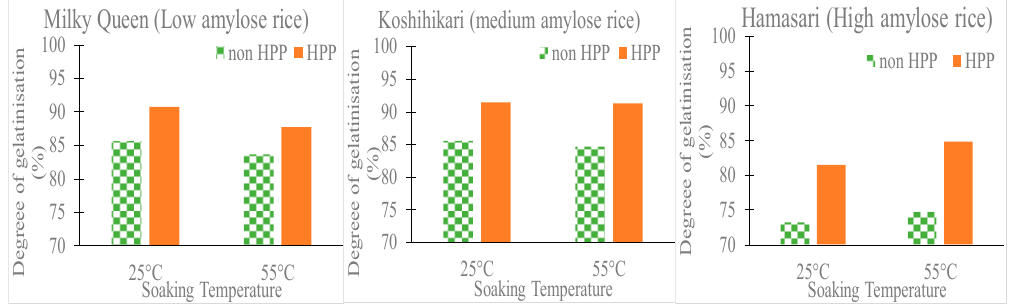
Figure 8. Comparison of the degree of gelatinization after cooking of three varieties of rice with different levels of amylose with their HPP treated counterparts (plotted using the data from Yamakura et al., 2005 [47]).